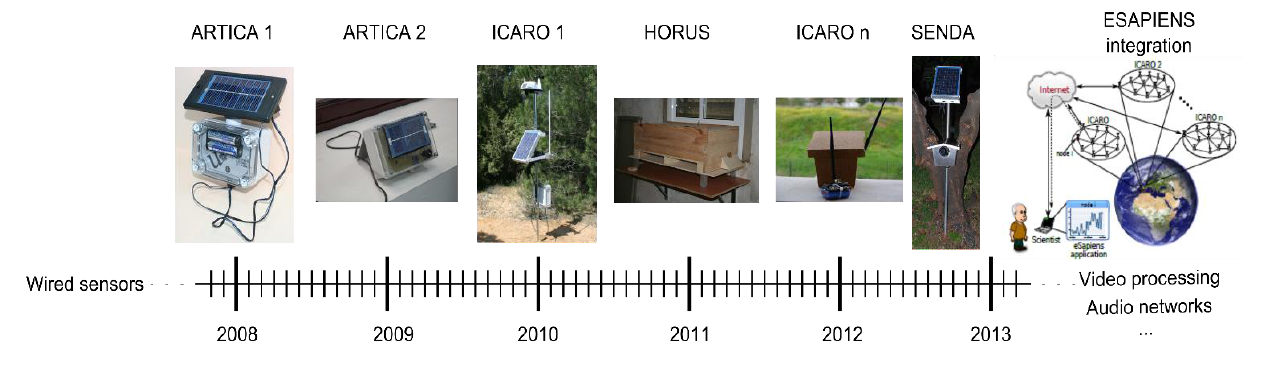
Figure 24. ESAPIENS architecture.